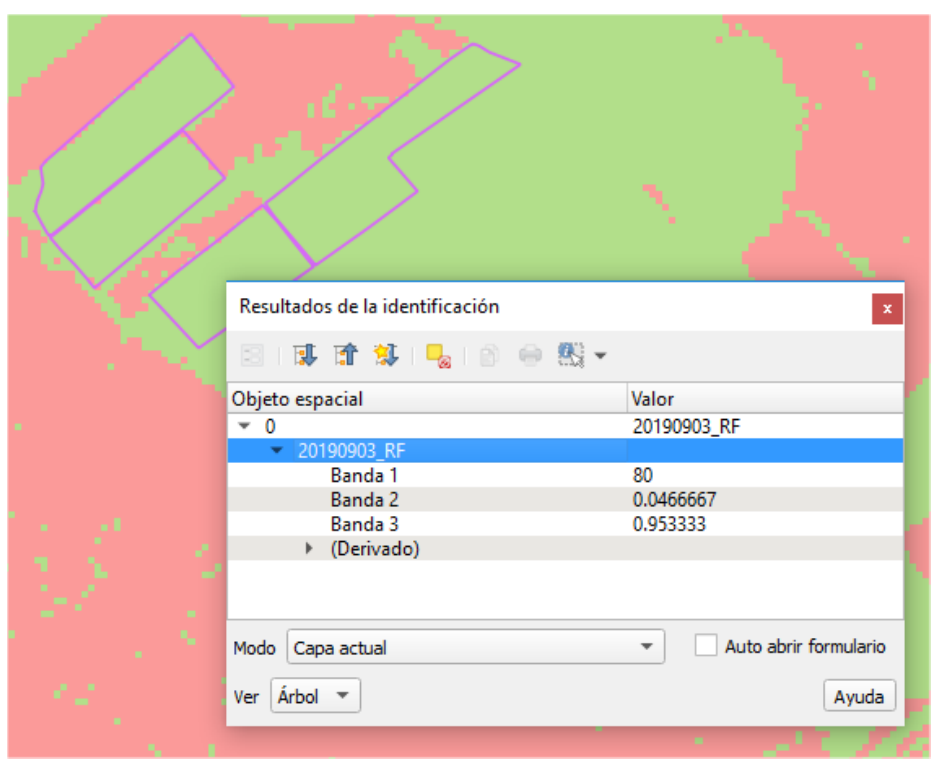
Figure 8. Raster resulting from the classification process with information about its bands through a GIS